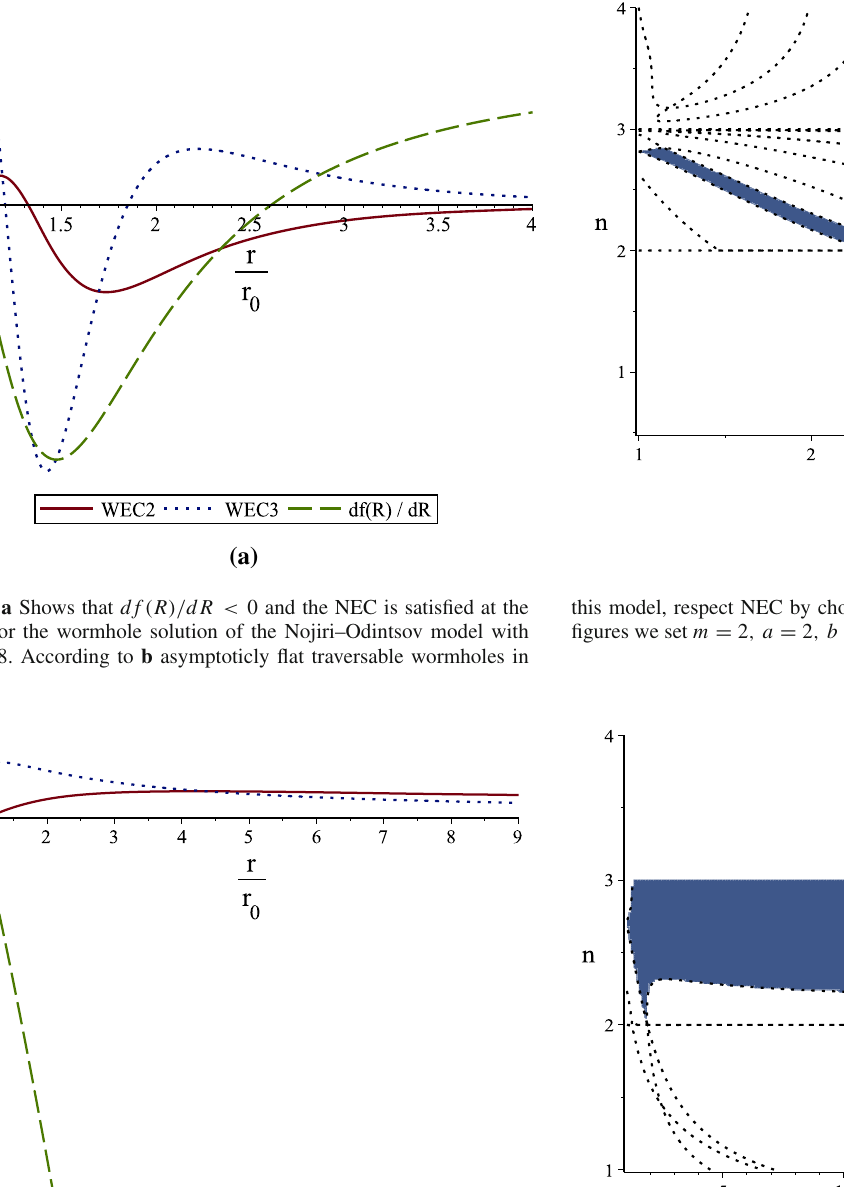
3) The Starobinsky model